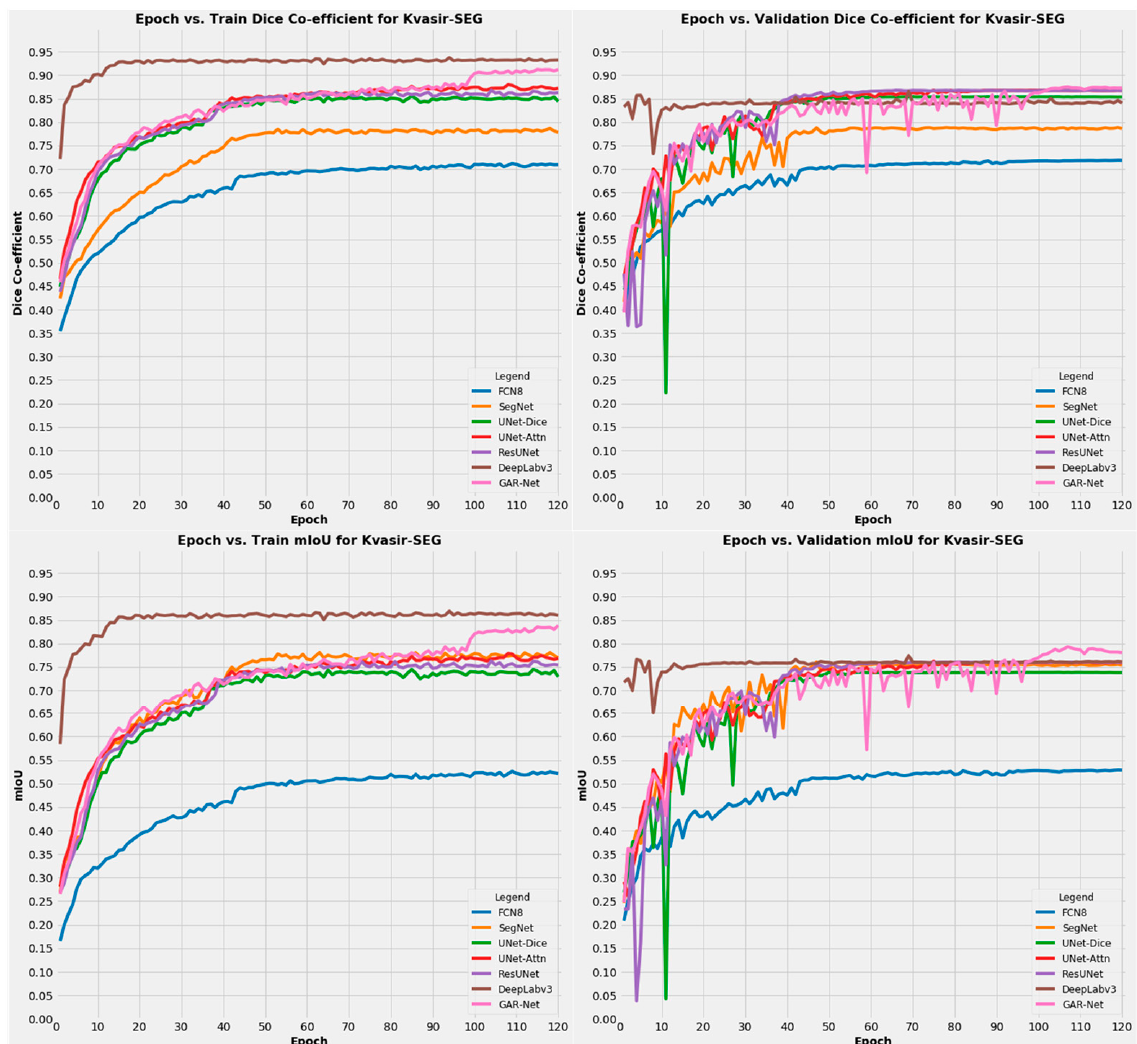
Figure 6. The Training and Validation Graphs for the Kvasir-SEG Dataset training.